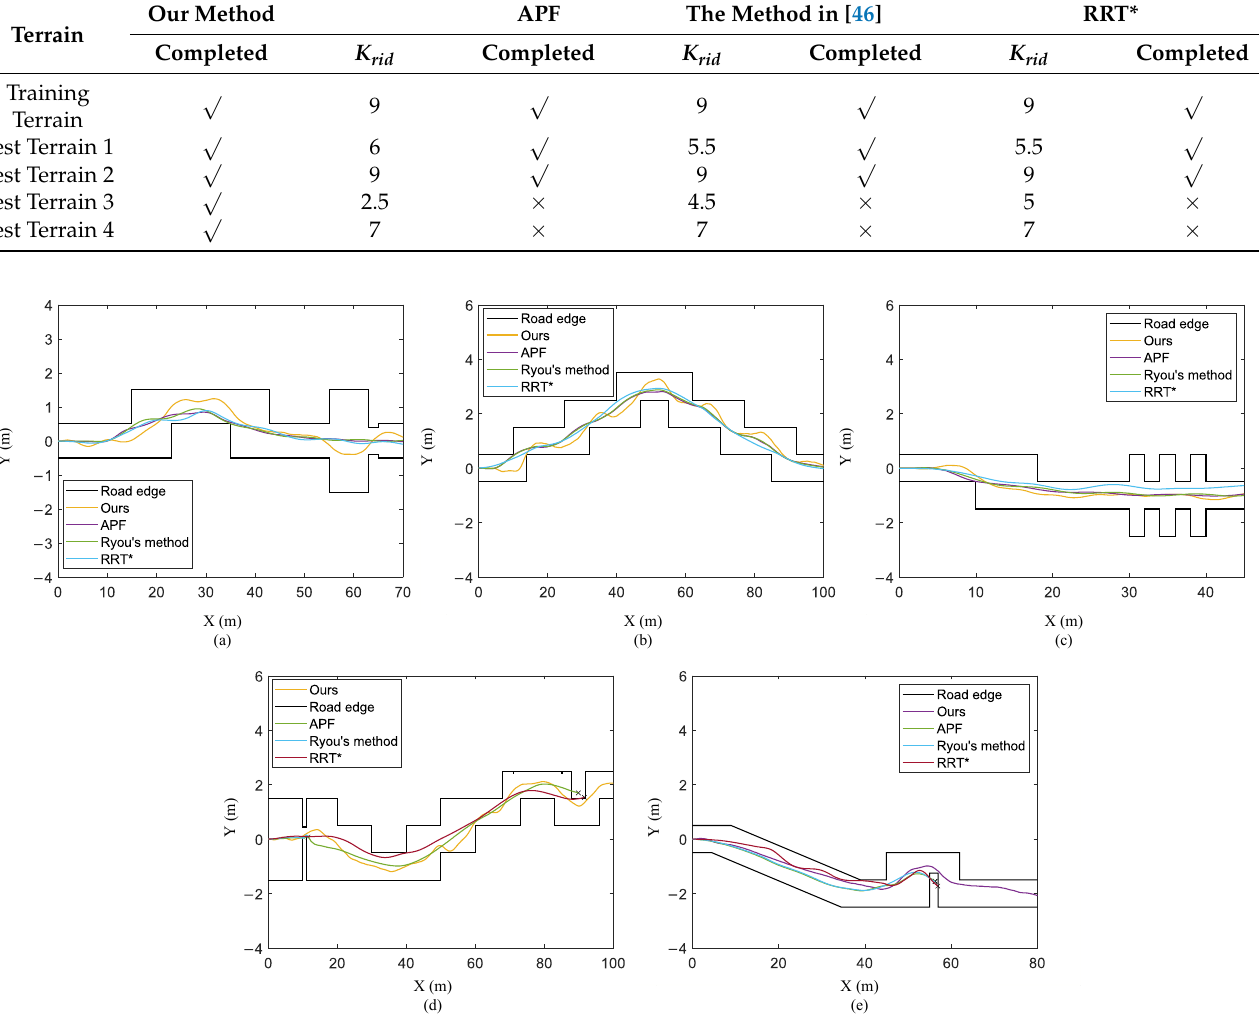
Table 2. Comparison with traditional planning and control methods.